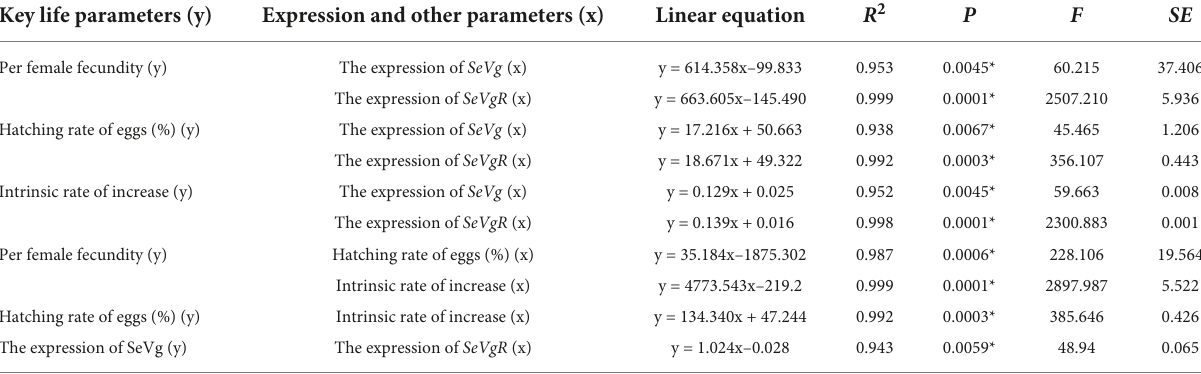
TABLE 3 The linear correlations between respective key life parameters and SeVgR / SeVg expression in S. exigua after